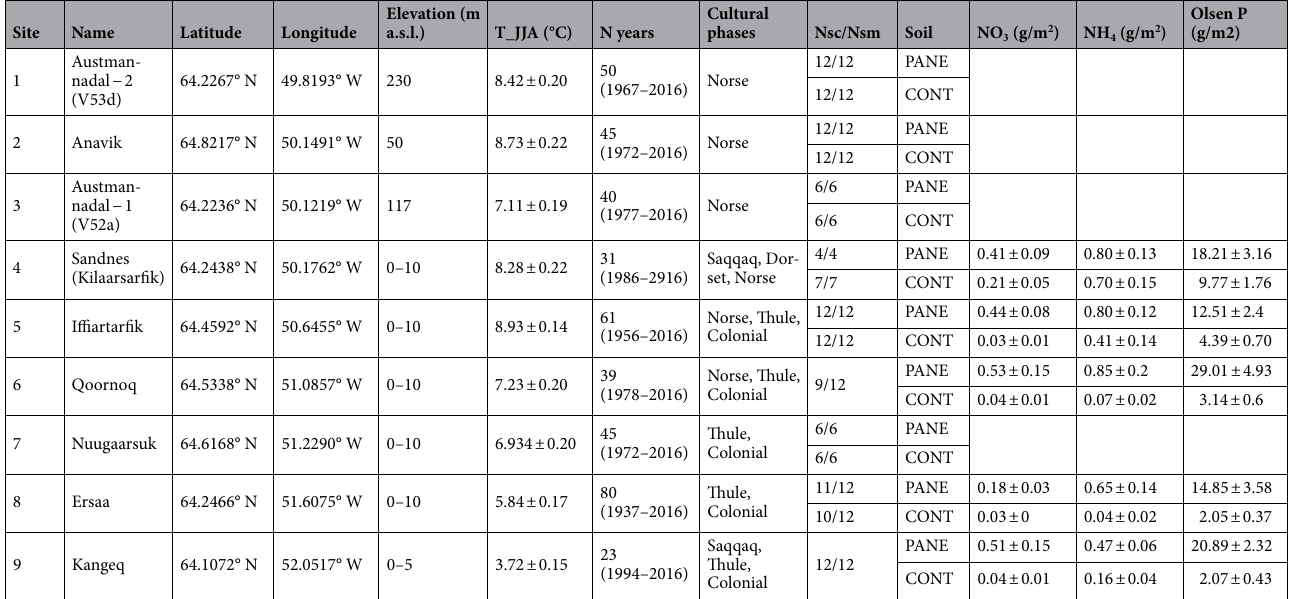
Table 1. Location of sites used for shrub sampling of Salix glauca L. in the Nuuk Fjord, Western Greenland and metadata for each site. T_JJA: Average summer temperatures of June, July and August ± standard error (see 16 ); N years: number of years measured; Nsc/Nsm: number of samples cross dated/measured; Depth- integrated soil content (0–35 cm) of NO 3 -N NH 4 -N and Olsen P based on soil samples from 3–8, 8–13, 18–23 and 28–33 cm depth 30 , given as mean ± standard error; Note: PANE = Past anthropogenic nutrient enrichment, CONT =